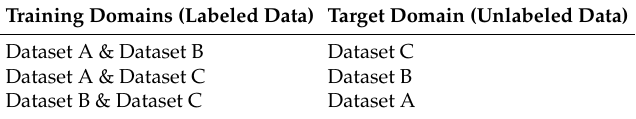
Table 9. Arrangement of the data for domain adaptation scenario